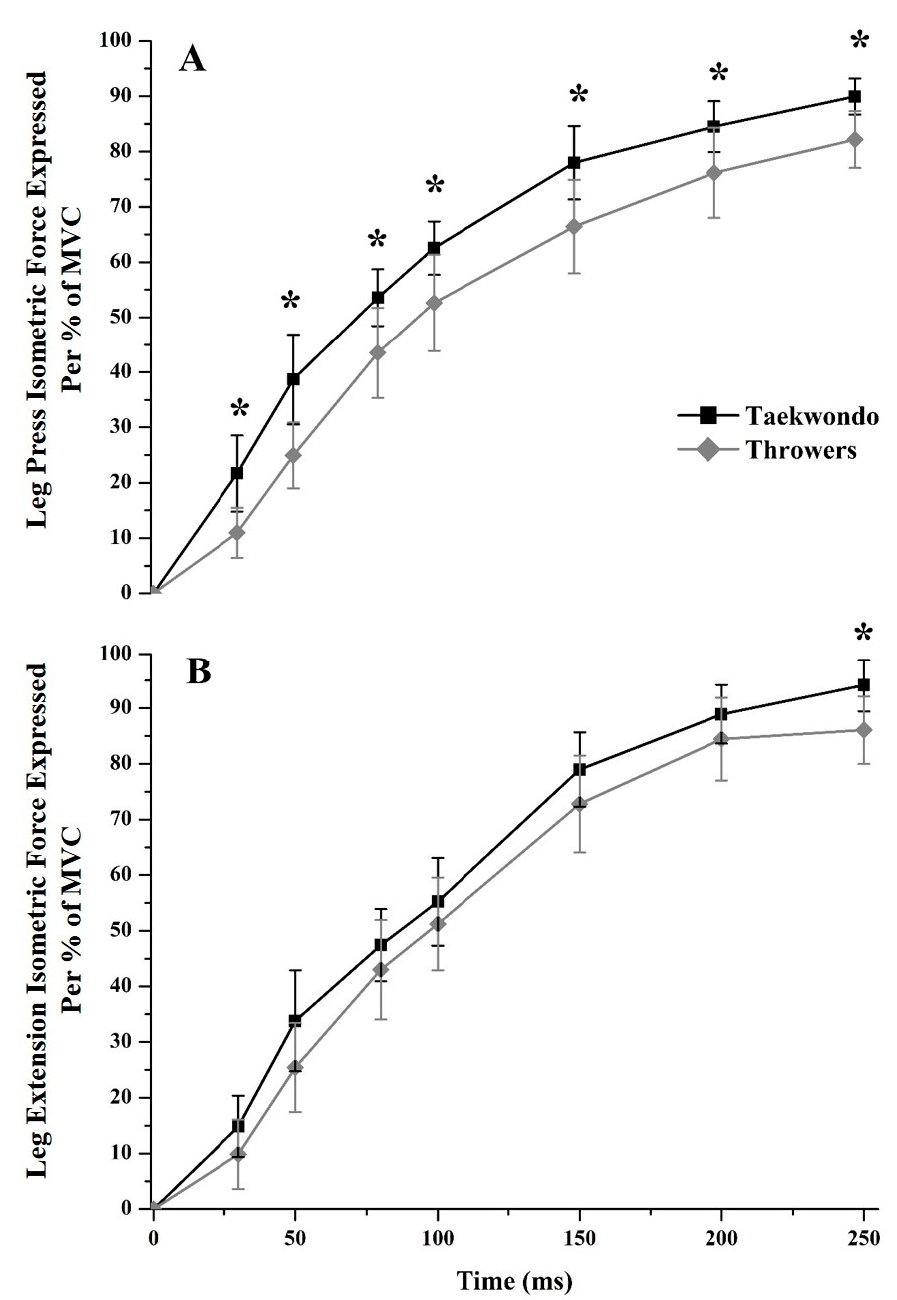
Figure 5. Leg press and leg extension isometric force production (IFP) expressed per maximum volunteer contraction (%MVC) for taekwondo athletes (black line) and track and field throwers (grey line). ( A ) Taekwondo had higher IFP %MVC than track and field throwers in all time moments for leg press IFP %MVC. ( B ) Taekwondo had higher leg extension IFP %MVC only during 250 ms as compared to thrower athletes (* p < 0.05).